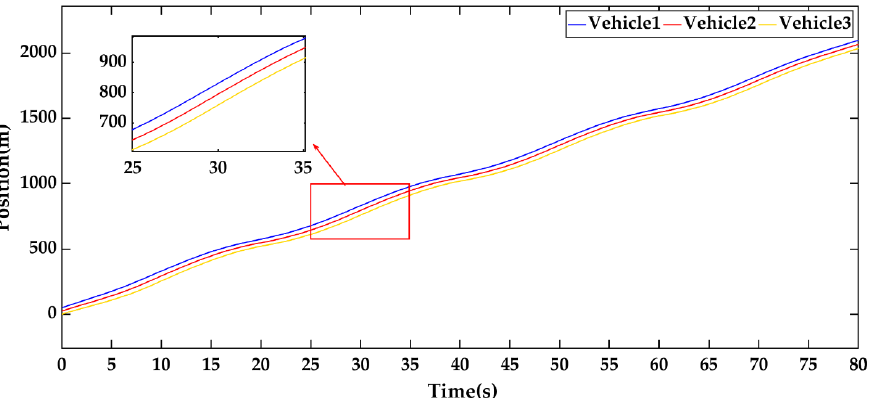
Figure 21. The positions of the following vehicle under the standard MPC strategy in Scenario 2.